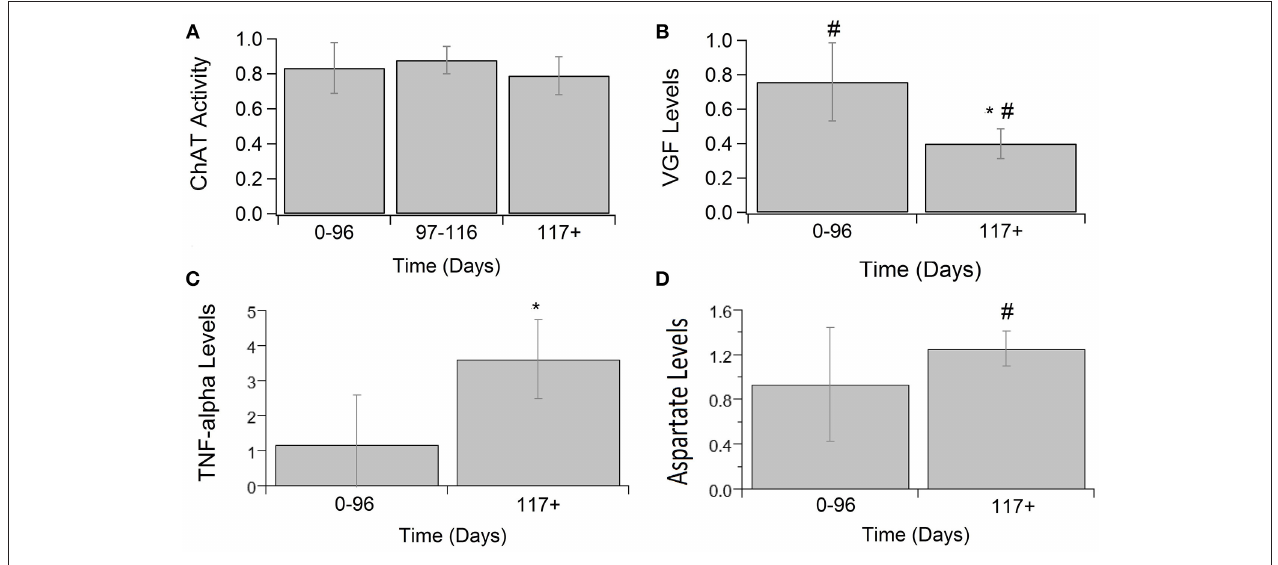
FIGURE 3 | Calcium-related cytokine levels over ALS disease progression. ChAT activity (A) , VGF (B) , TNF α (C) , and aspartate (D) averages in SOD1-G93A normalized to wild type (ratio presented as SOD1-G93A/WT) in three stages: 0–96 days, 97–116 days, and 117 + days. SOD1-G93A VGF levels were significantly decreased compared to WT at 0–96 days (# p = 0.0036) and 117 + days (# p < 0.0001). SOD1-G93A VGF levels at end-stage are also significantly lower than early-stage (* p = 0.0002). TNF α (* p = 0.0488) and aspartate (# p = 0.0350) levels were significantly increased at end-stage compared to WT. Error bars represent SD.